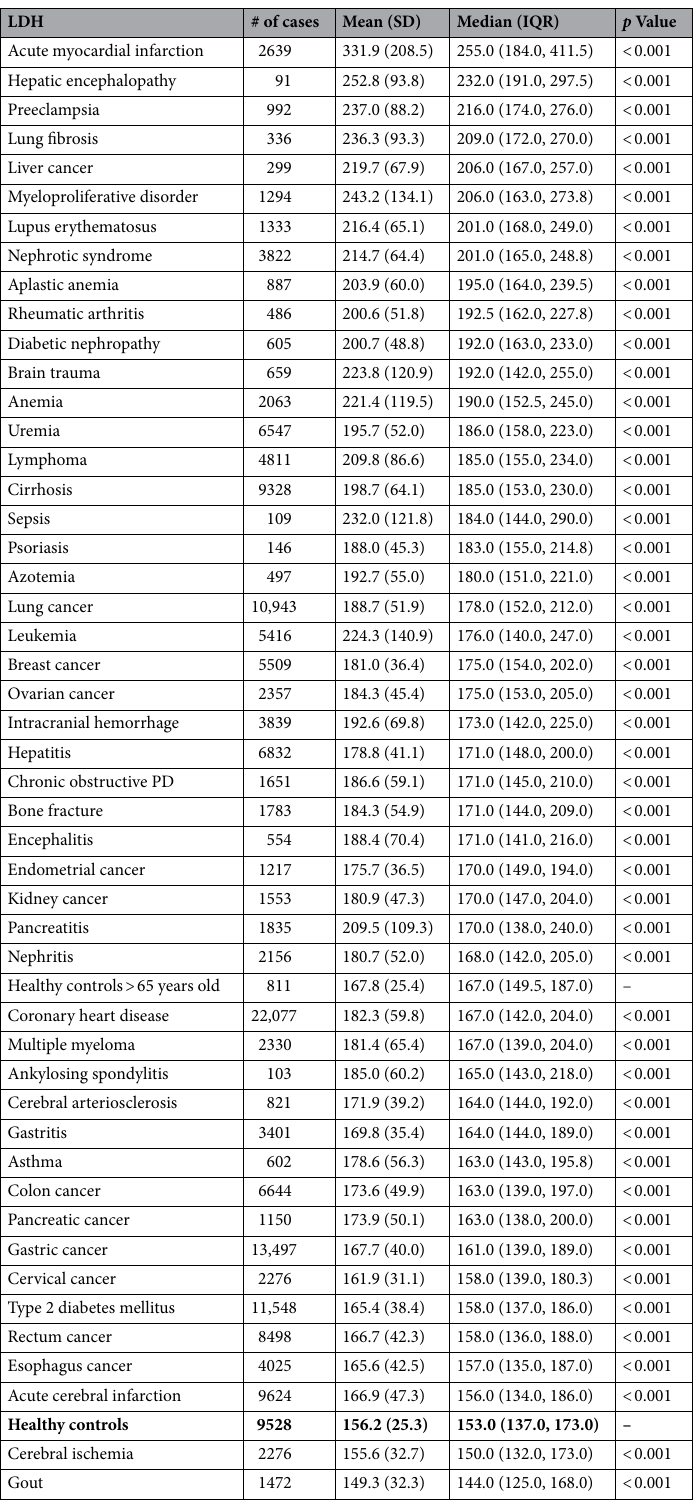
Table 1. Serum LDH activities (U/L) in 48 different types of clinical defined human diseases and healthy controls. The healthy control is bolded for easy comparison to the different types of diseases listed. SD standard deviation, IQR interquartile range, Chronic Obstructive PD Chronic Obstructive Pulmonary